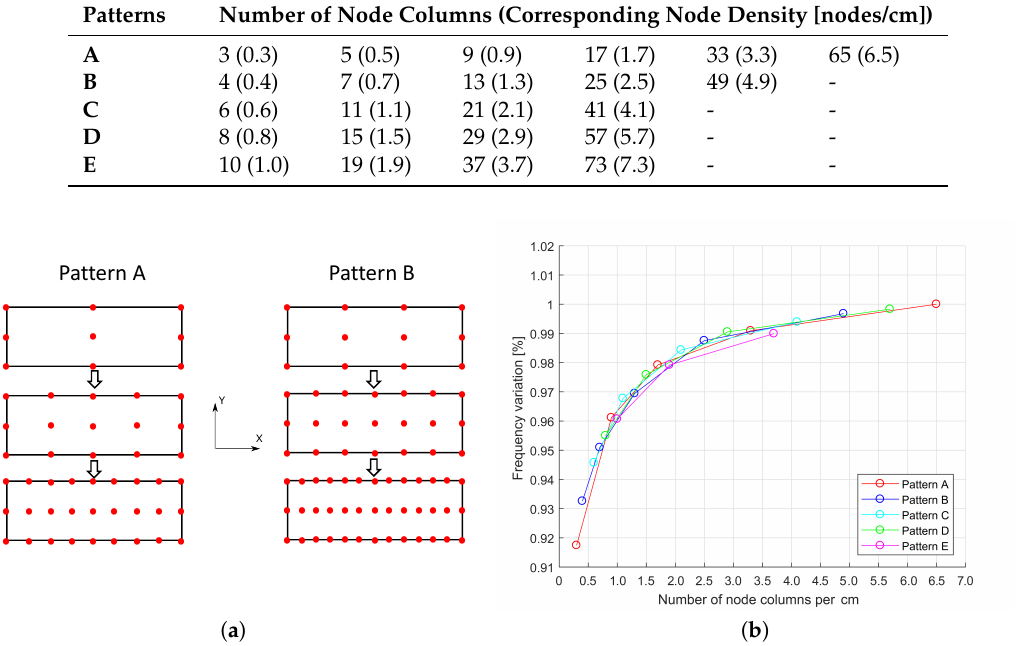
Figure 8. ( a ) Blade-strip contact patch discretization. ( b ) Frequency variation produced by variable number of master contact nodes.